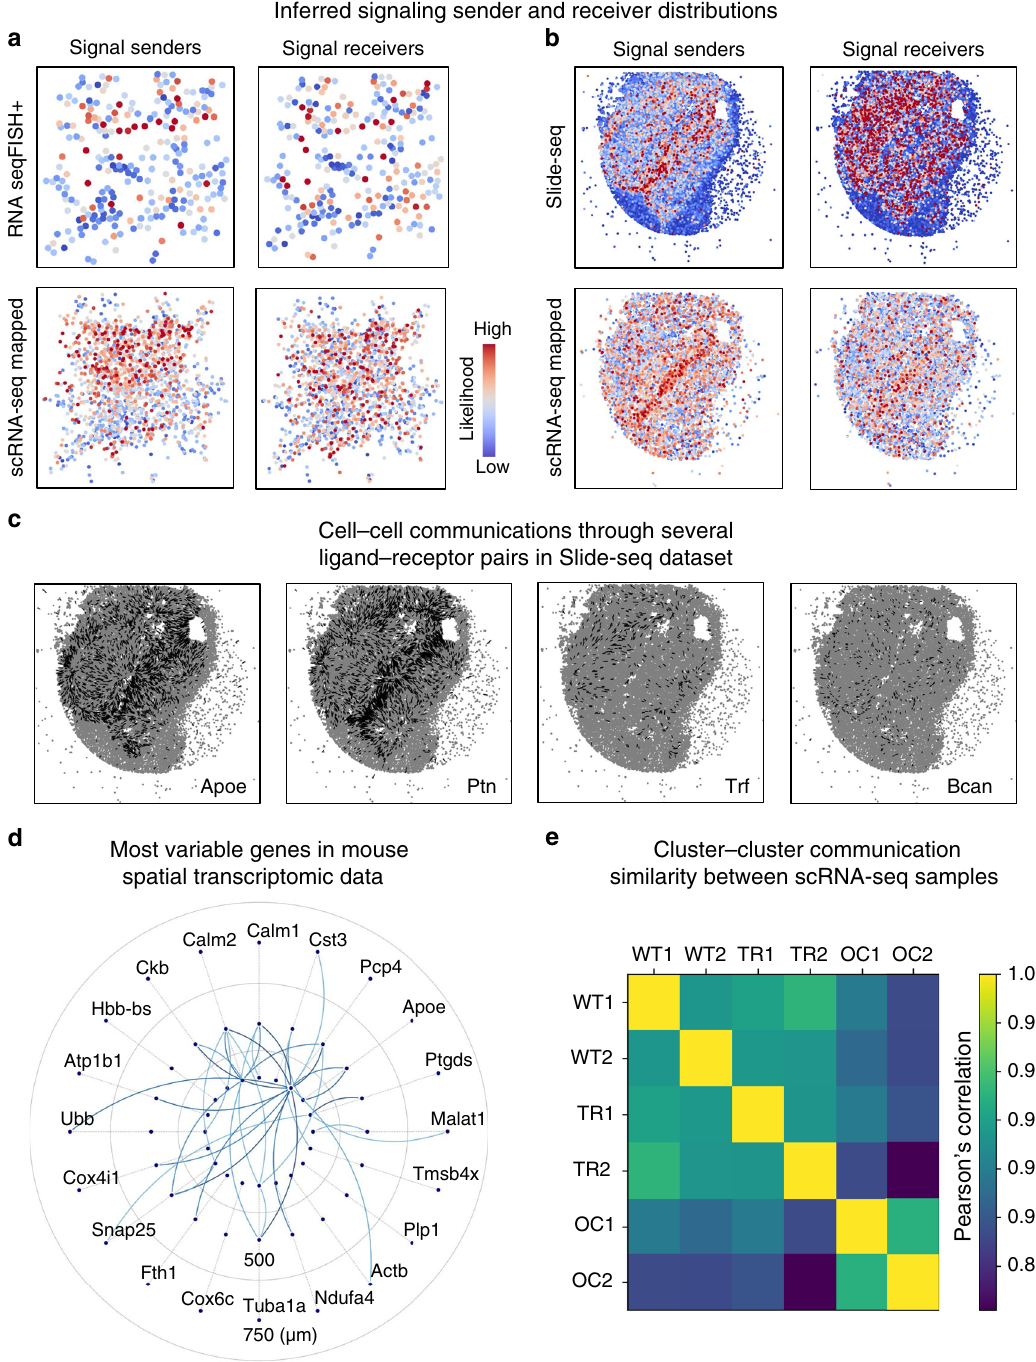
Fig. 6 Application of SpaOTsc to spatial transcriptomic data and their integrations with scRNA-seq datasets. The Slide-seq data, the RNA seqFISH + data, and the scRNA-seq data for mouse olfactory bulb were taken from ref. 51 , ref. 52 , and ref. 53 , respectively. a, b Spatial distributions of signal senders and receivers with the color showing the likelihood of being a sender or receiver. Top row: inference using only spatial transcriptomics data. Bottom row: the inferred signaling in scRNA-seq data (sample WT1) visualized by mapping the single cells to space using spatial transcriptomic data. c Signaling for four individual marked ligands in the Slide-seq data. d The intercellular gene – gene regulatory information fl ow of the top 20 variable genes in the Slide-seq data. e Similarities on cluster – cluster communication between the six samples of the scRNA-seq data integrated with the RNA seqFISH + data measured by Pearson ’ s correlation coef fi